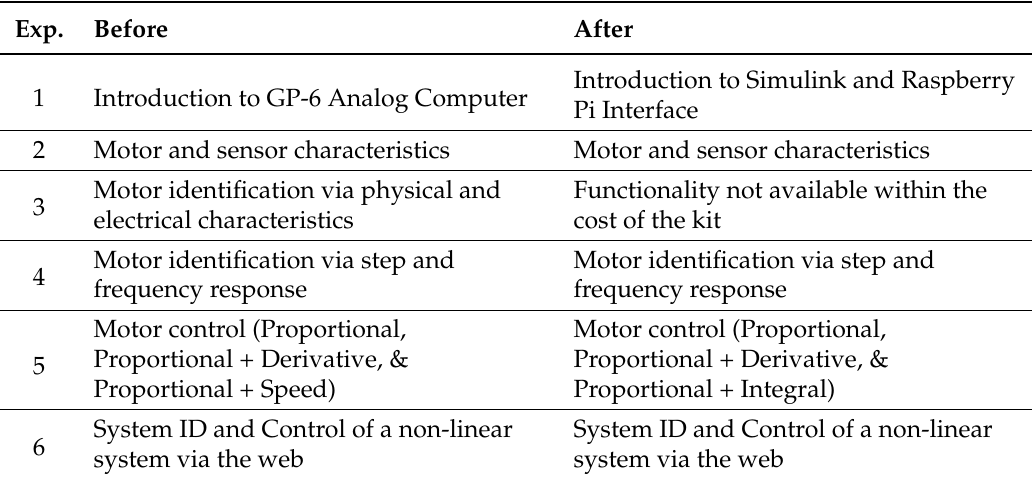
Table 2. Comparison of GE 320